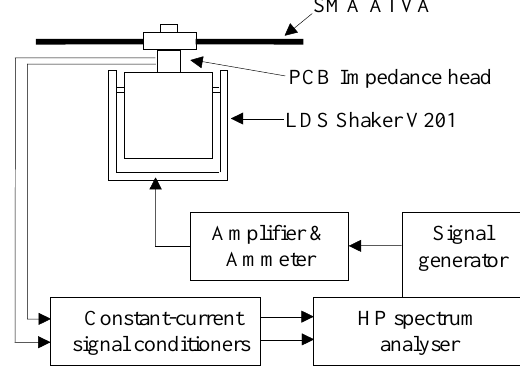
Fig. 11. Experimental set-up to measure the dynamic characteristics of an SMA